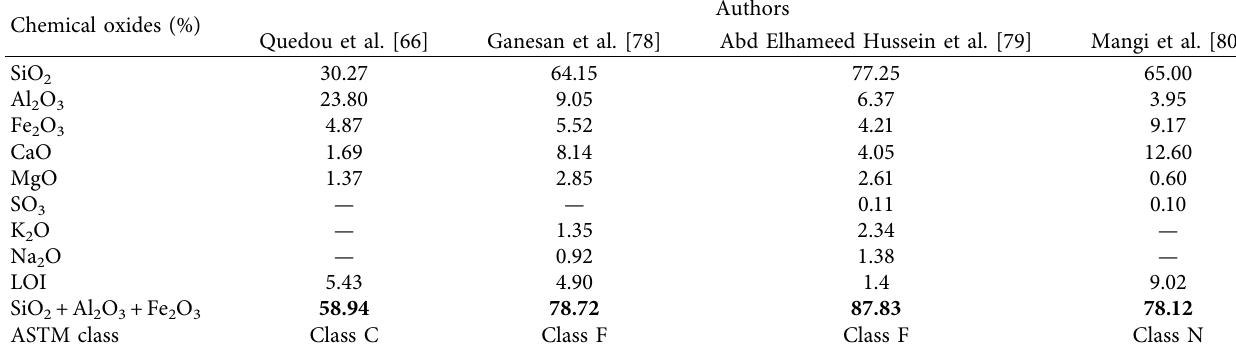
Table 7: Chemical compositions of SCBA.